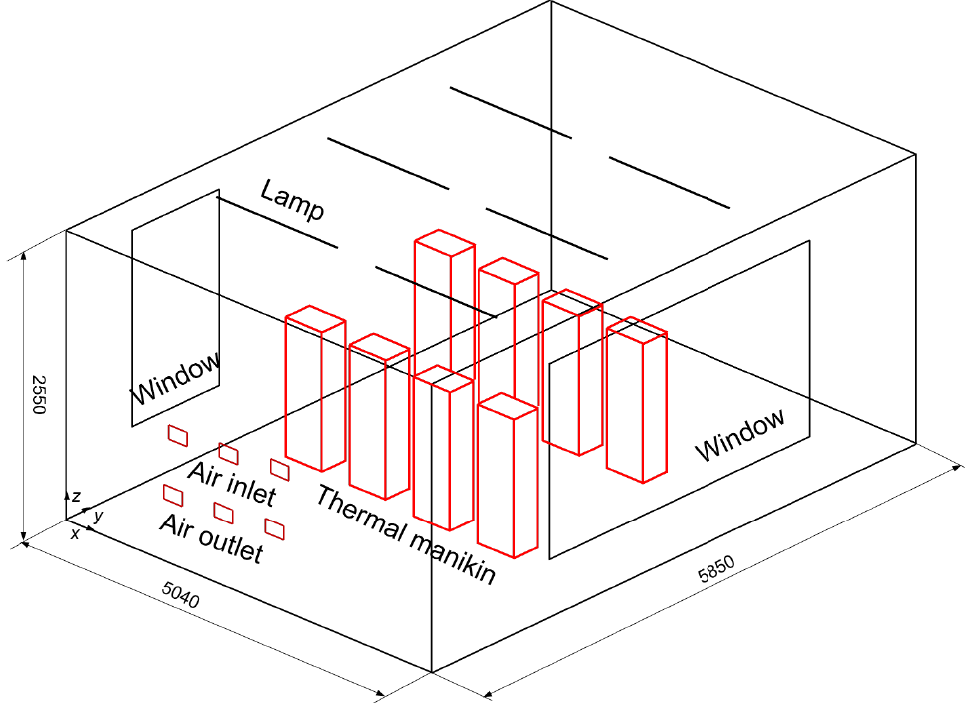
Figure 4. Computational model (unit: mm).